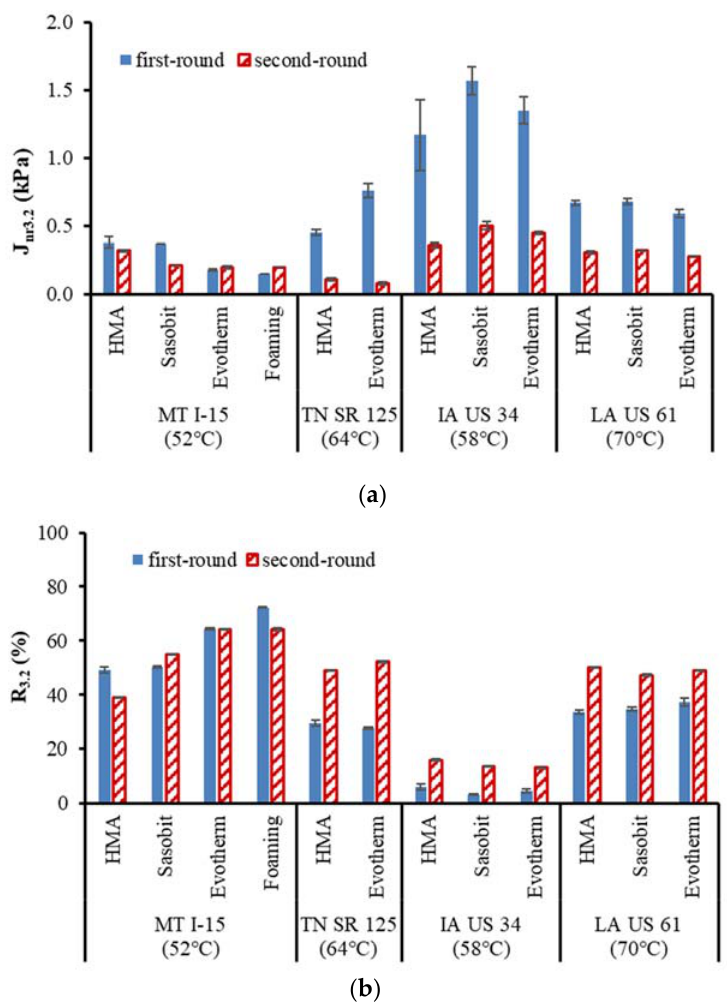
Figure 5. Comparisons of recovered binder MSCR results ( a ) Jnr3.2 , and ( b ) R3.2 . Note: the number shown in the parenthesis indicates test temperatures.